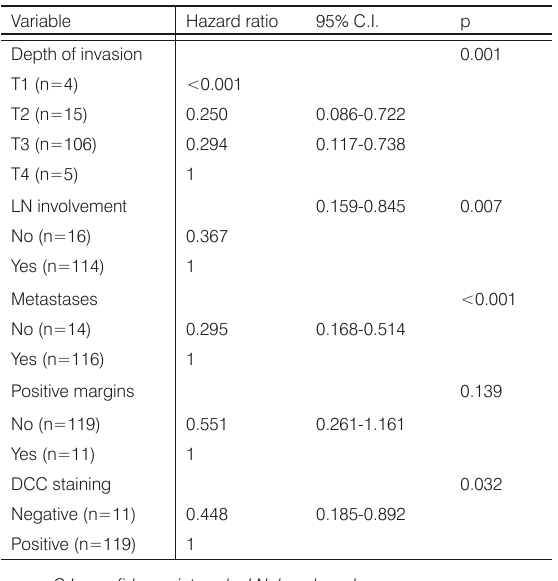
Figure 5. Overall survival (OS) after curative resection according to DCC expression.